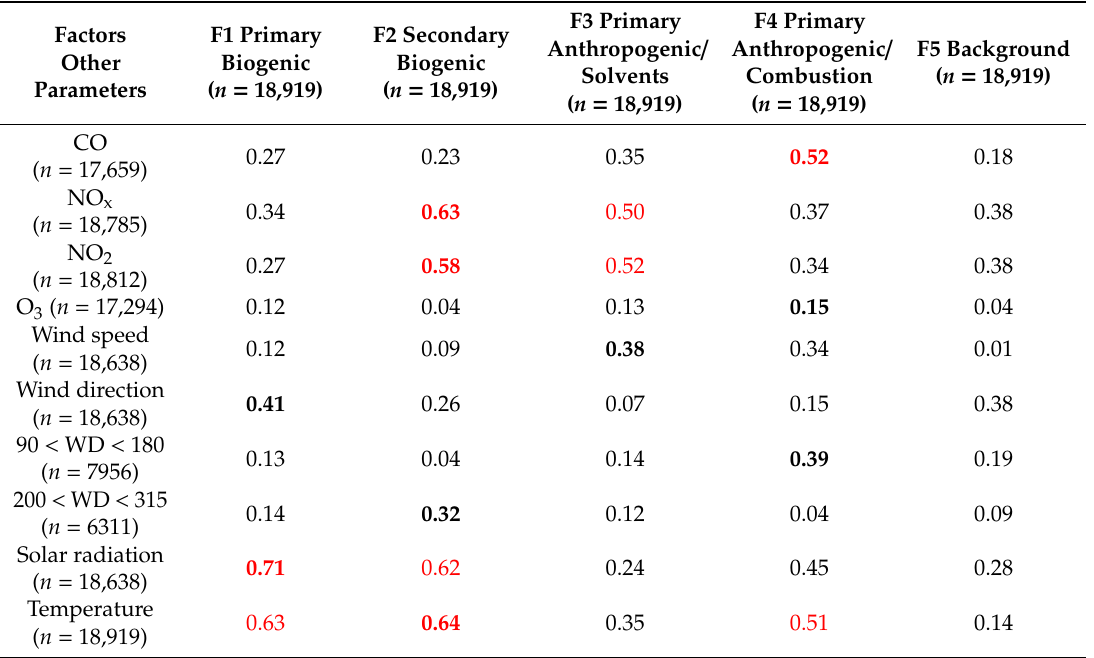
Table 3. Determination coe ffi cients ( R 2 ) between gases and meteorological parameters and factors. Red, strong correlation; black, weak correlation; bold, highest correlation for one parameter; n, number of data used for the